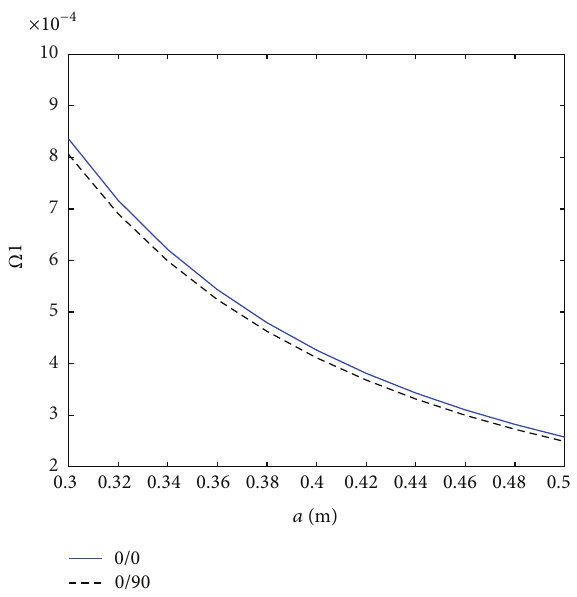
Figure 8: Variation of the first mode natural frequency with the radius of the plate for different layups and clamped-clamped boundary condition ( 𝑏 = 0.05 m, ℎ 𝑐 = 0.001